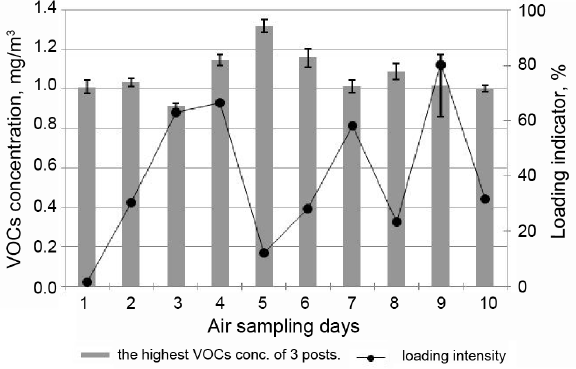
Fig. 3. Dispersion of VOCs concentration and loading indicator in